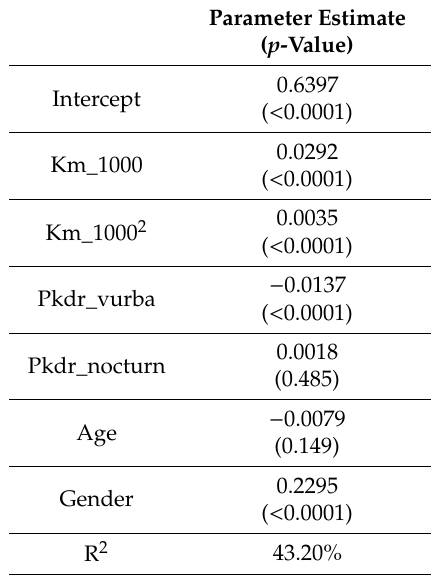
Table A1. Parameter estimates of the linear regression model. In the model, Tolerkm / 1000 is the dependent variable and km_1000 (km / 1000) and km_1000 2 are introduced in the model instead of lnkm as independent